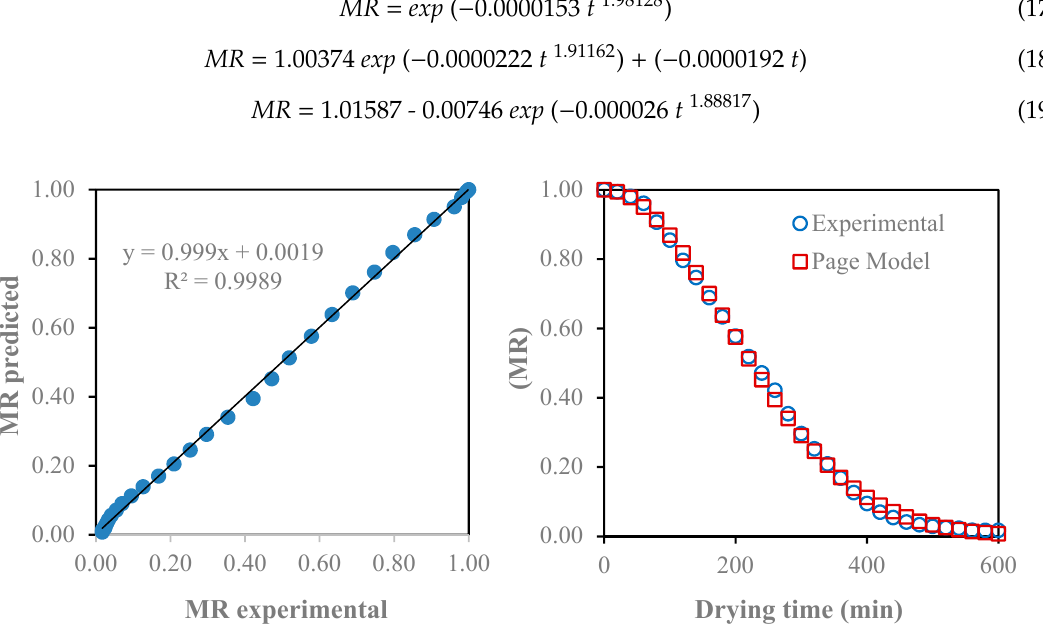
Figure 4. Validation of experimental and predicted moisture ratio values from the Page model.